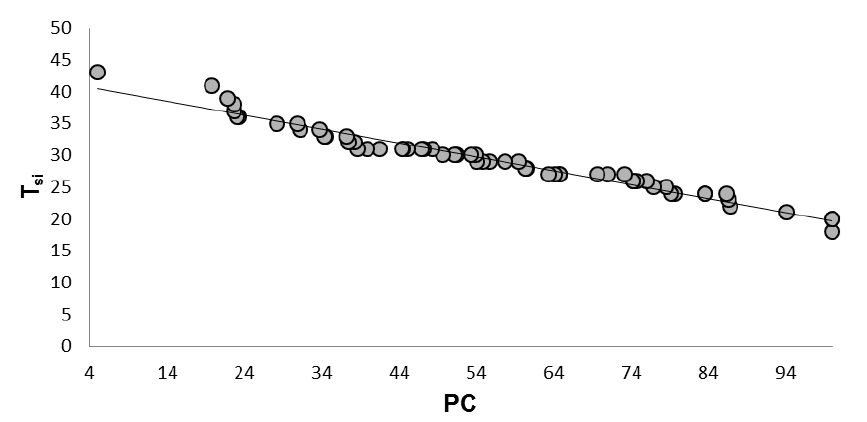
Figure 4. Relation between plant cover (PC) and inner burrow substrate temperature (T flavomarginatus burrows.